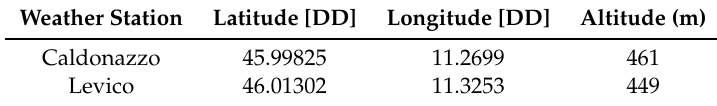
Table 1. Geographical coordinates of the weather stations for Example